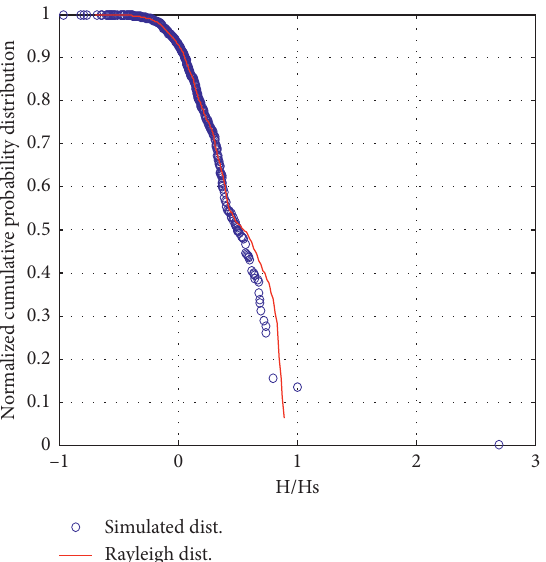
Simulated dist. Rayleigh dist. Figure 8: Comparison of normalized cumulative probability distribution of Rayleigh distribution and simulated freak